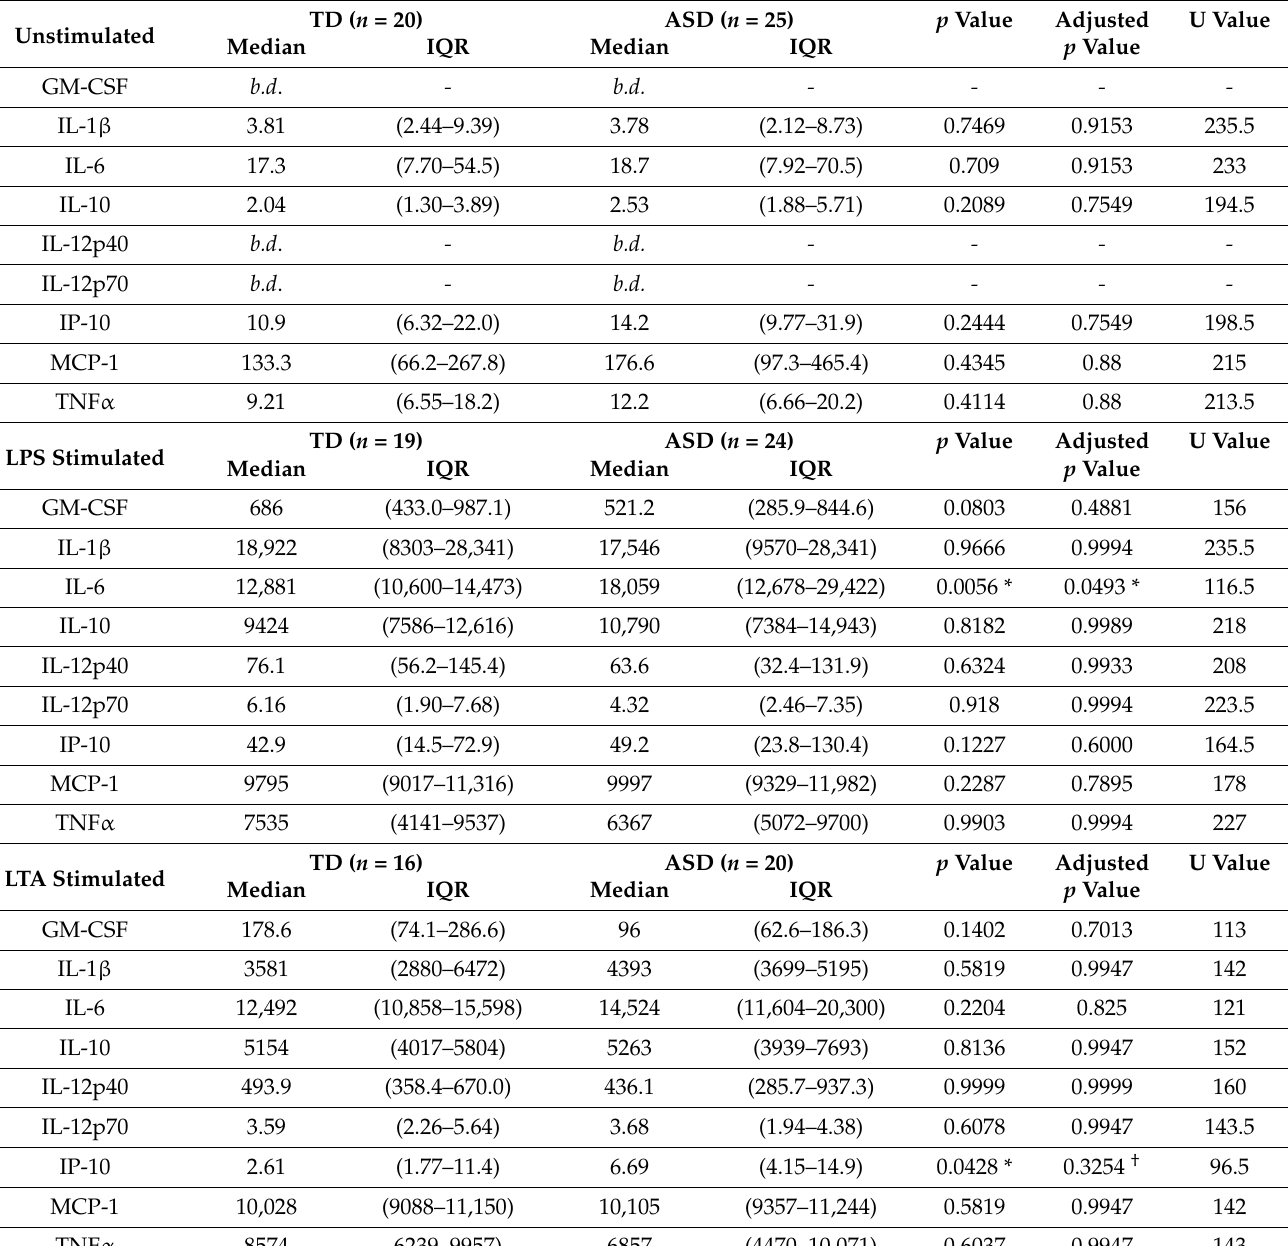
Table 1. Monocyte cytokine production under each of three conditions. Table includes concentrations of cytokines produced at baseline (unstimulated), or after LPS or LTA stimulation, with data presented as median (IQR) pg/mL. Cytokine concentrations produced by TD monocytes were compared to concentrations produced by ASD monocytes under each condition. After correcting for multiple comparisons, monocytes from autistic children had a significant increase in IL-6 production after LPS